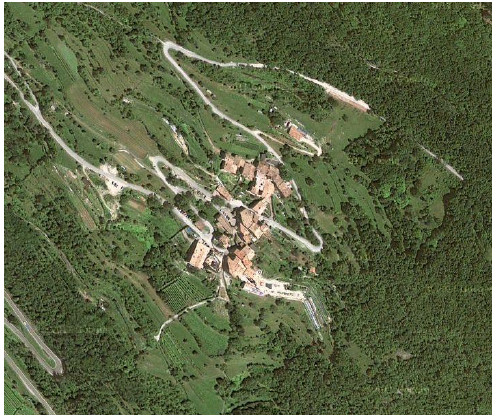
Figure 8: An aerial view of Calvola di